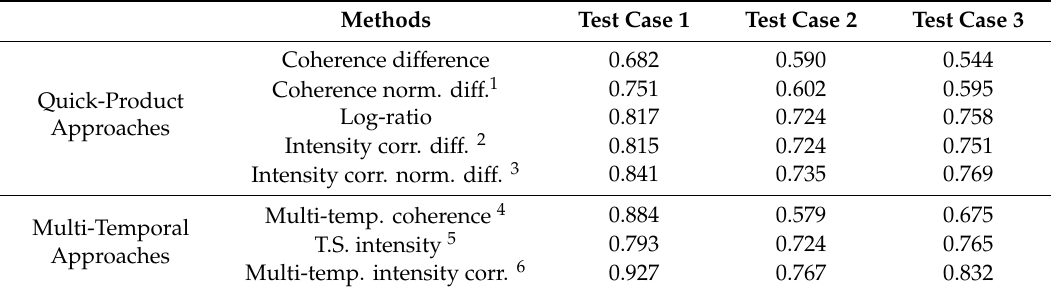
Table 1. Area Under Curve (AUC) of Receiver Operating Characteristic (ROC) curves of each method.